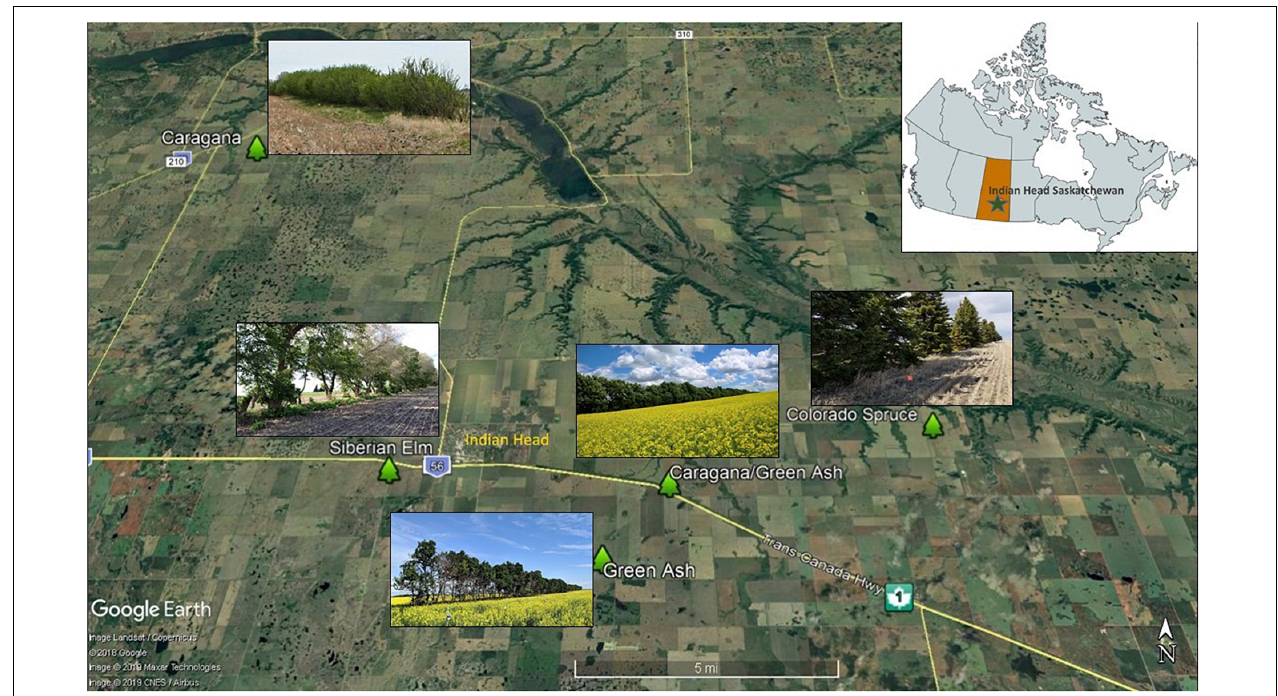
FIGURE 1 | Physical location map of measured shelterbelts near Indian Head, SK, Canada. Inset-map of Canada with a green asterisk showing geographical location of Indian Head, SK,